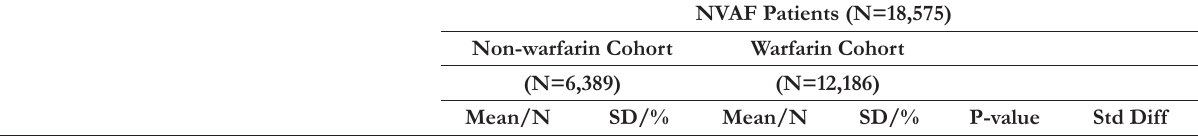
Table 4. Descriptive Statistics for NVAF Patients Prescribed Warfarin or Not